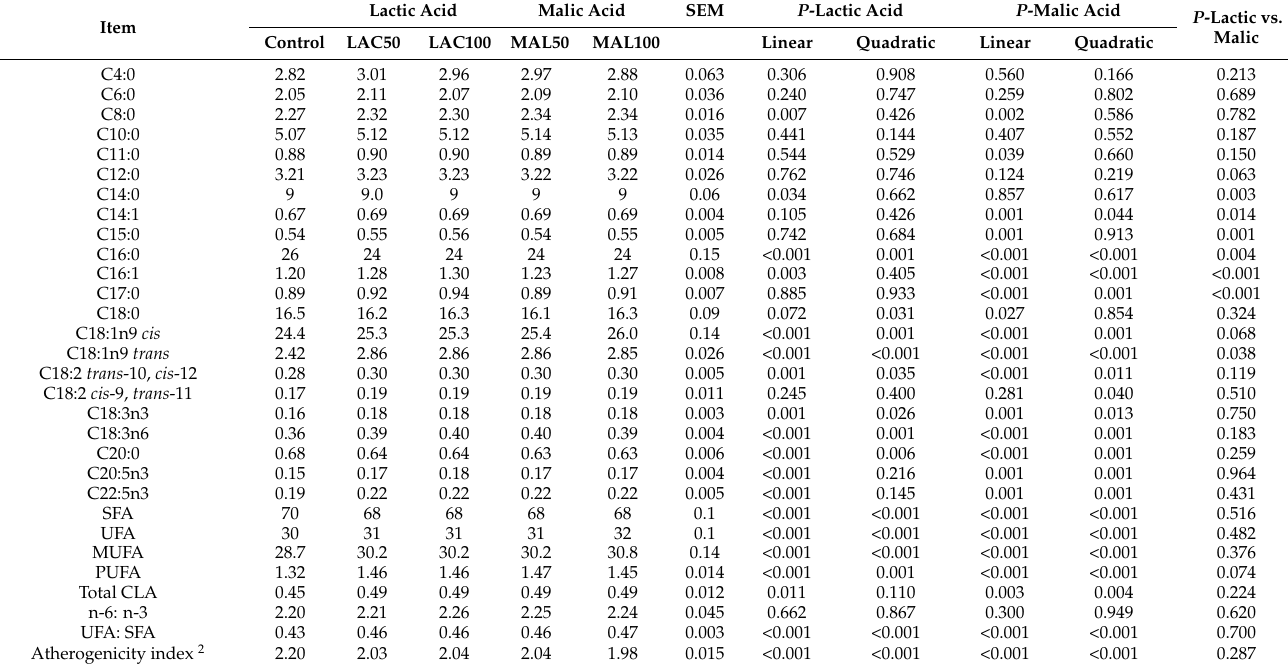
Table 5. Milk fatty acid profile (g/100 g fatty acids) of lactating Farafra ewes fed a diet containing date palm leaves (DPL) ensiled without additives or ensiled with lactic acid or malic acid 1